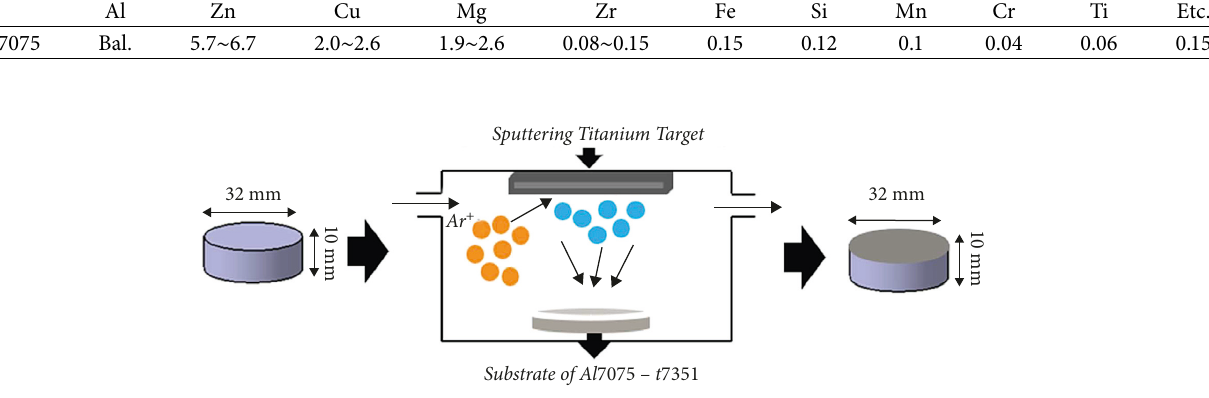
Figure 1: Schematic of the DC magnetron sputtering. Table 3: Experimental parameters of surface roughness tests. Table 5: Experimental parameters of wear